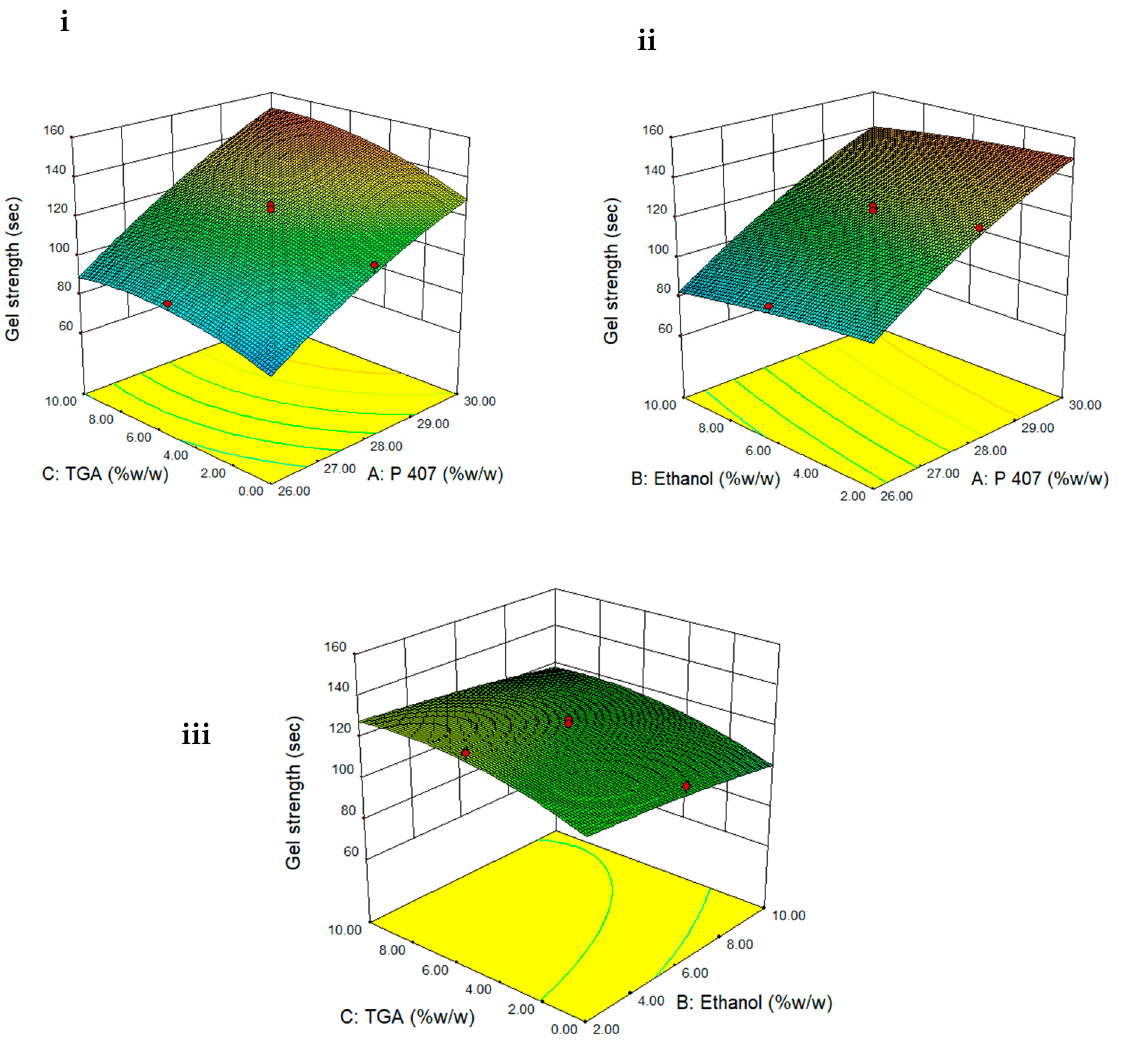
Figure 3. Three-dimensional surface plots showing effect of ( i ) TGA and P407 concentration on gel strength when ethanol is constant, ( ii ) ethanol and P407 concentration on gel strength when TGA is constant and ( iii ) TGA and ethanol concentration on gel strength when P407 is constant.